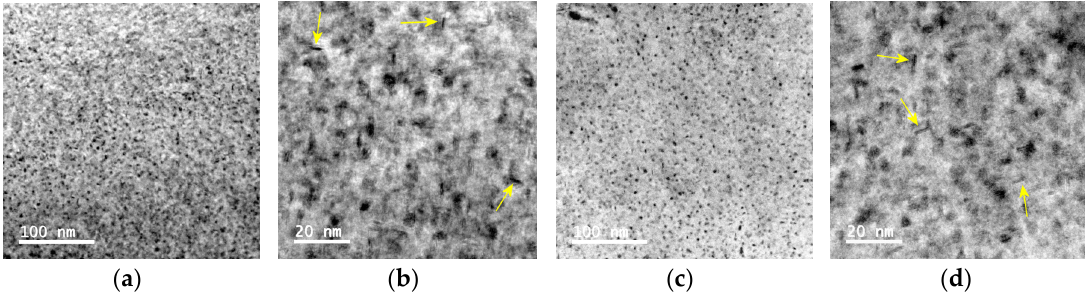
Figure 7. Representative TEM micrographs of the Al 7075 at the peak hardened conditions with ( a , b ) 0% straining with aging for 24 h (equivalent to Al 7075-T6); and ( c , d ) pre-straining for 15% at 480 °C with aging for 12 h: ( a , c ) are taken at lower magnifications and ( b , d ) are taken at higher magnifications. It is important to mention that several elongated ellipsoidal particles are observed with most other particles in a spherical shape and the ellipsoidal particles are indicated by yellow arrows in Figure 7b,d. The appearance of the ellipsoidal particles is due to the higher content of Cu in the Al